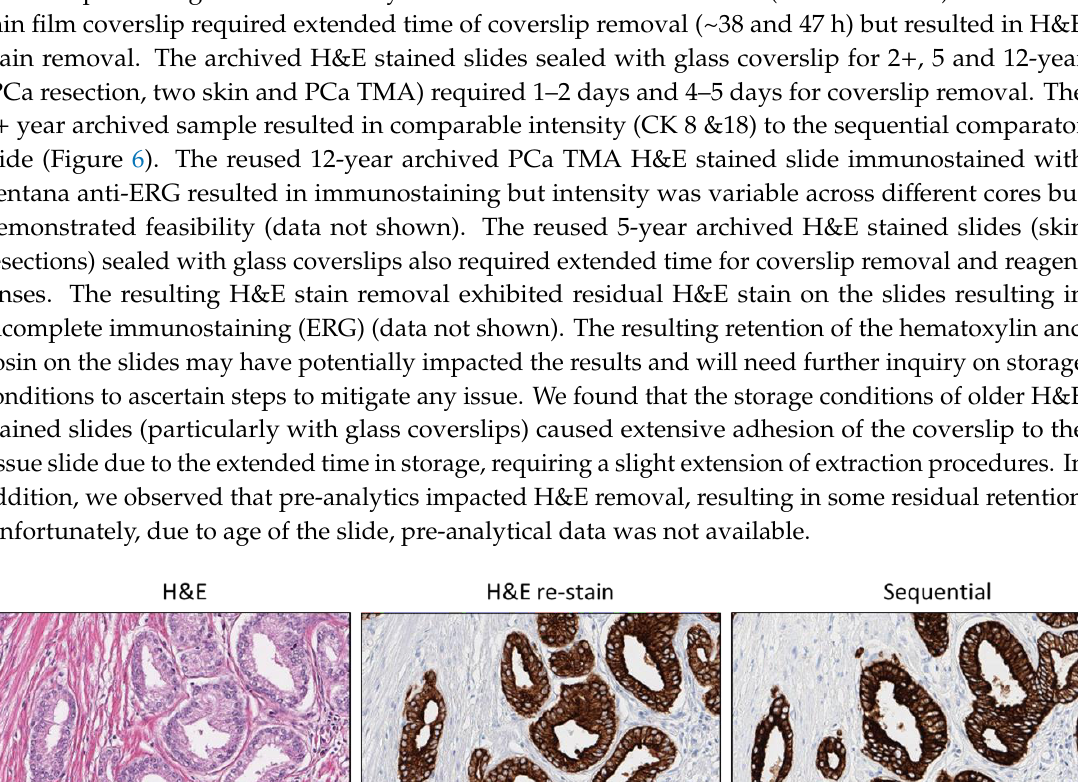
Abbreviation: int ctrls, internal controls.